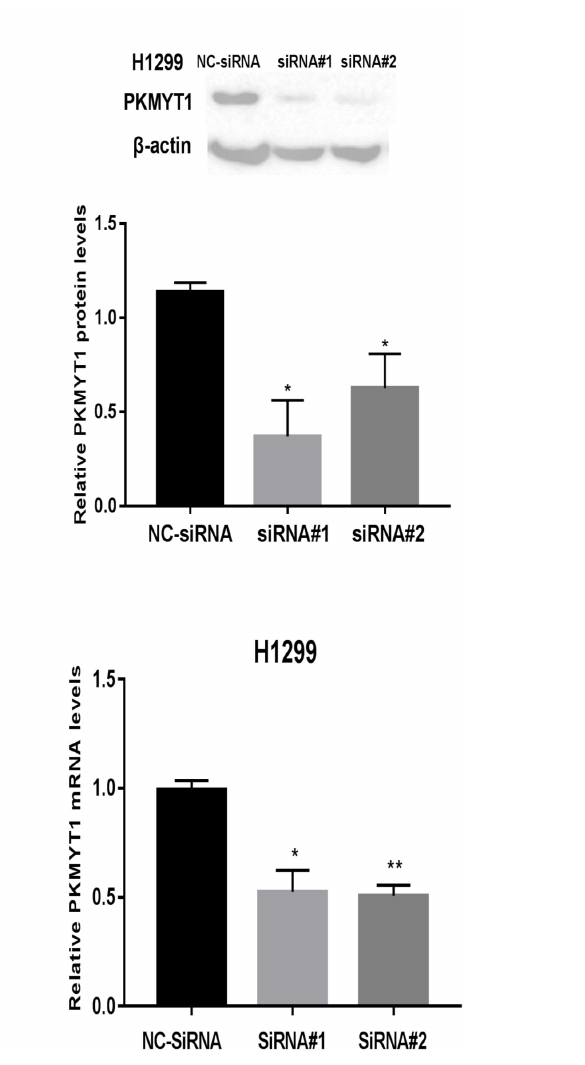
FIGURE 6 | Silencing efficiency of PKMYT1 in A549 and H1299 cells. (A) Western blotting assays detected the relative PKMYT1 protein levels in A549 and H1299 cells after transfecting with siRNA#1, siRNA#2, and NC-siRNA. (B) Q-PCR assays detected the relative PKMYT1 mRNA levels in A549 and H1299 cells after transfecting with siRNA#1, siRNA#2, and NC-siRNA. * p < 0.05, ** p <